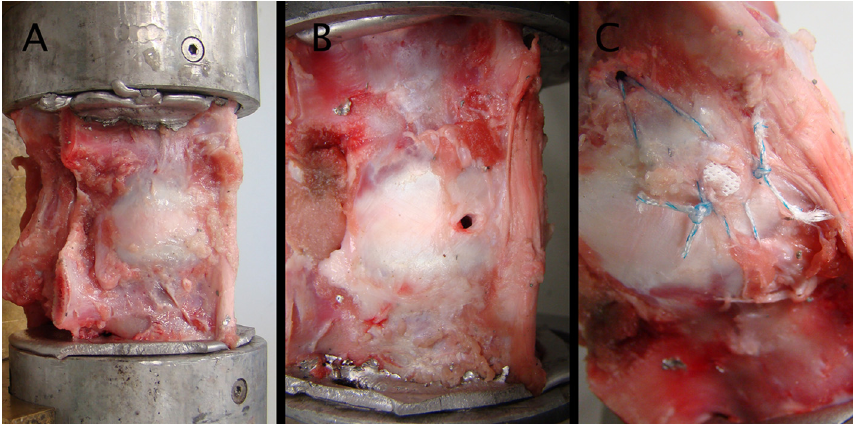
Figure 2. Each motion segment had the same test three times. A: in healthy native condition, B: with a 3mm defect in the annulus fi brosus, C: after closing the defect with scaffold and soft anchors. Both ends are embedded in bismuth to insure rigid fi